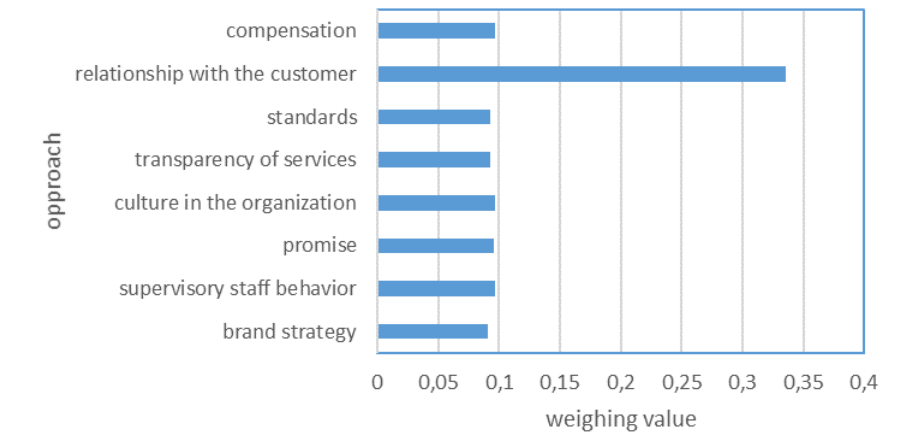
Figure 5: Result of organization sub criteria weighing value (Inconsistency ratio=0.00)